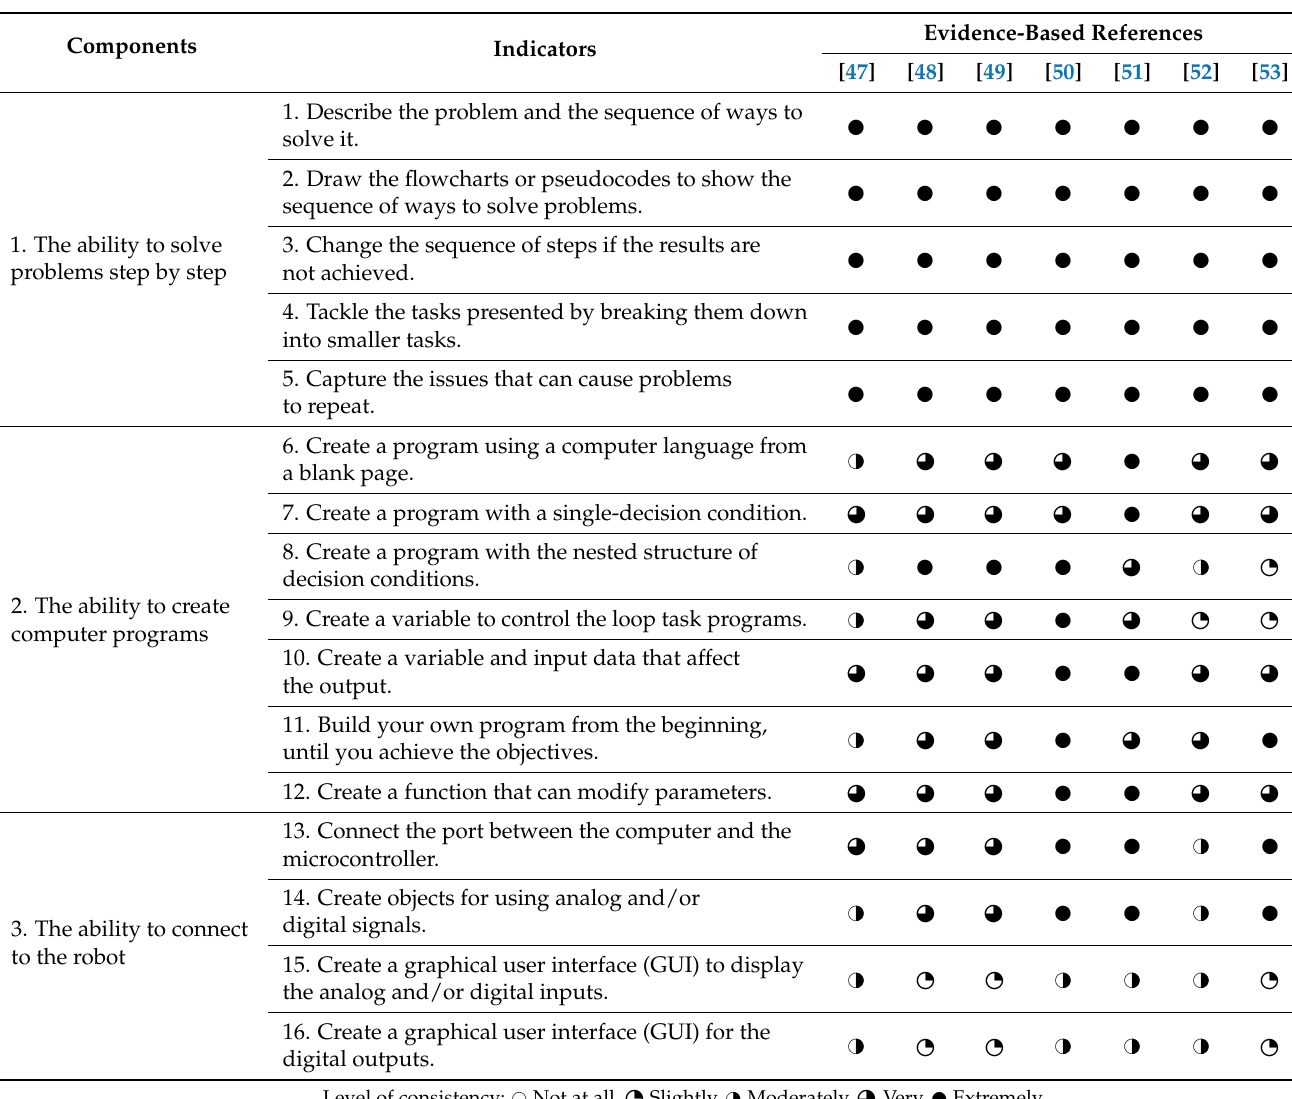
Table 6. The synthesis of the components and indicators of the robot programming skill assessment based on higher order thinking.